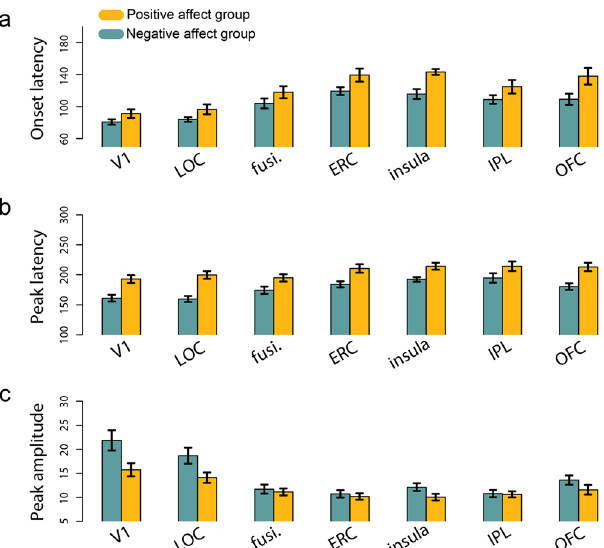
Figure 2. Regions of interest and average stimulus-evoked responses. Top-left: ventral, medial, and lateral views of the left hemisphere of an inflated brain showing a representative set of ROI labels. Note that we generated anatomically-constrained, functionally-defined ROIs for each individual participant. Surround: mean stimulus- evoked responses extracted from each region of interest and averaged across hemispheres (with SEM range shaded). Maroon = V1, blue = lateral occipital complex, orange = fusiform cortex, teal = entorhinal cortex, yellow = insula, green = inferior parietal lobule, purple = OFC. Shaded region indicates standard error of the mean.